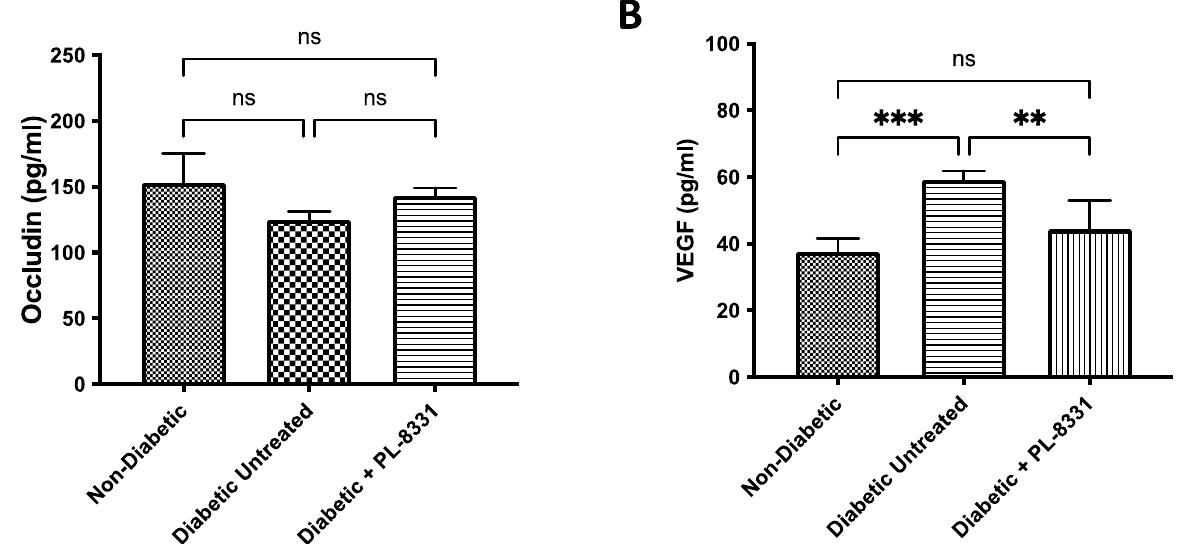
Figure 4. Effects of PL-8331 on the neuroretinal expression of Occludin and VEGF. The neuroretina was collected, homogenized, and assayed by ELISA for Occludin and VEGF. ( A ) The level of Oc- cludin in the neuroretinal homogenates from diabetic mice was not significantly (ns) different from non-diabetic or PL-8331-treated diabetic mice. ( B ) The levels of VEGF expressed in neuroretinal homogenates from diabetic mice were significantly greater than those from the neuroretina of diabetic mice treated with PL-8133 (** p ≤ 0.01) and non-diabetic mice (*** p ≤ 0.005); N = 10. There was no statistical (ns) difference in neuroretinal VEGF levels between non-diabetic and PL-8331-treated diabetic